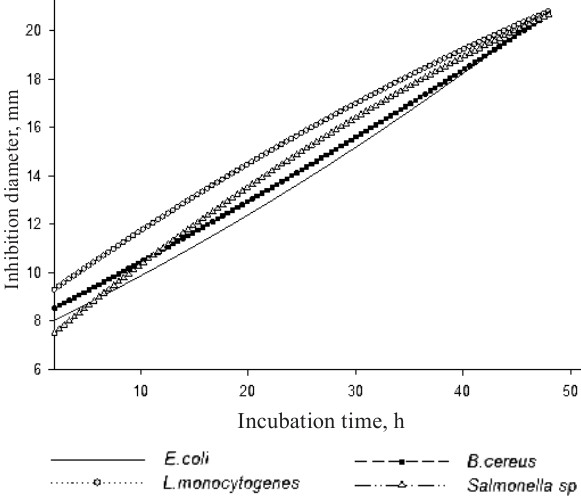
Figure 1 Effect of incubation time on inhibition of pathogenic bacteria